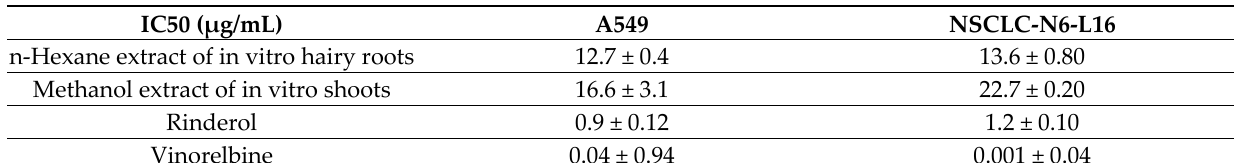
Table 2. Results of cytotoxicity on human lung cancer cell lines (IC50) of R. graeca in vitro cultivated shoots and hairy roots extracts, pure rinderol, and vinorelbine.